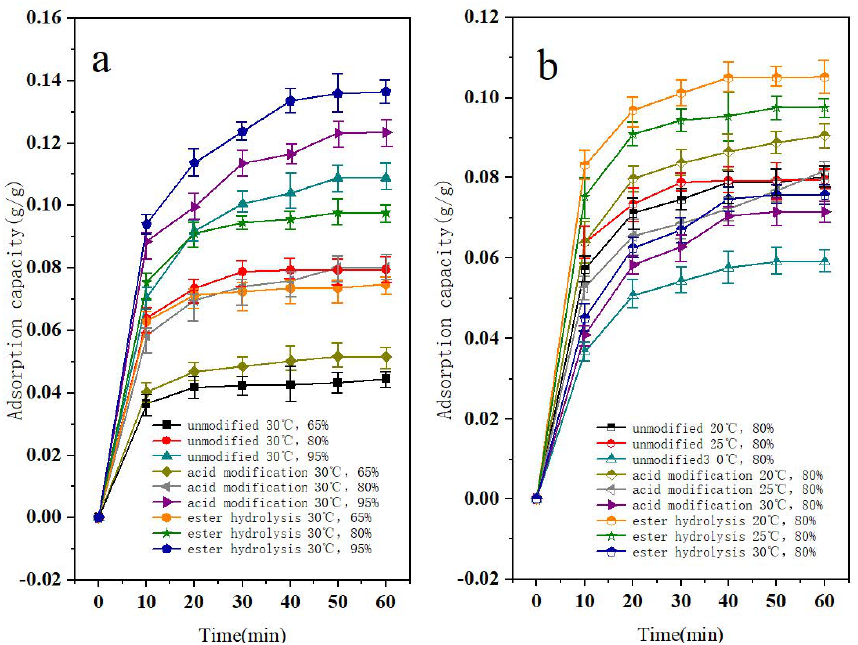
Figure 8. Dynamic adsorption curves of activated carbon under ( a ) the same temperature and different humidity, and ( b ) the same humidity and different temperature.